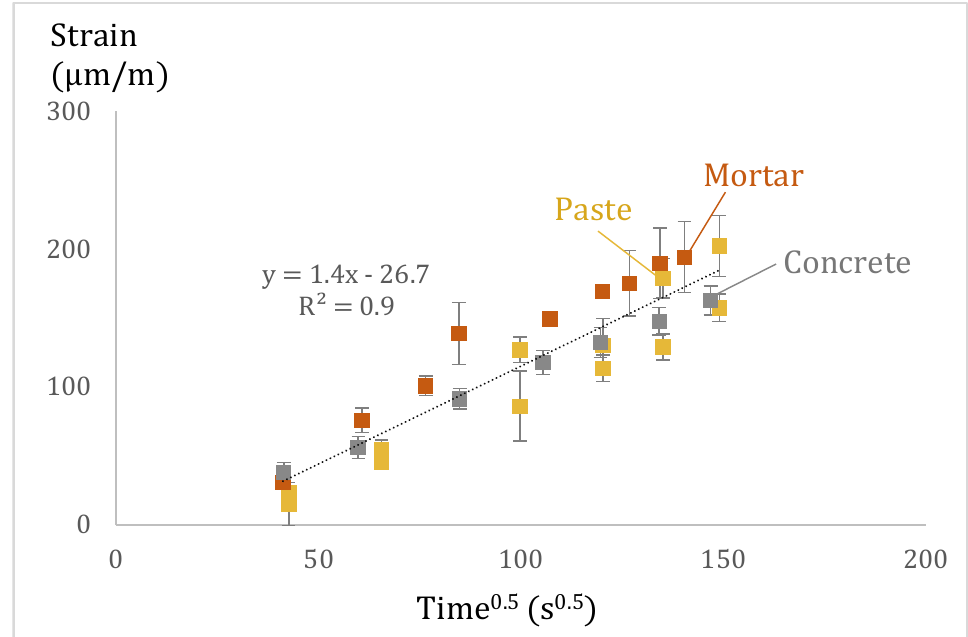
Figure 11. Horizontal strain variation of paste (data from this study), mortar, and concrete (data from [13]) as a function of the square root of time. The dotted line is the linear least-squares fit to the data.